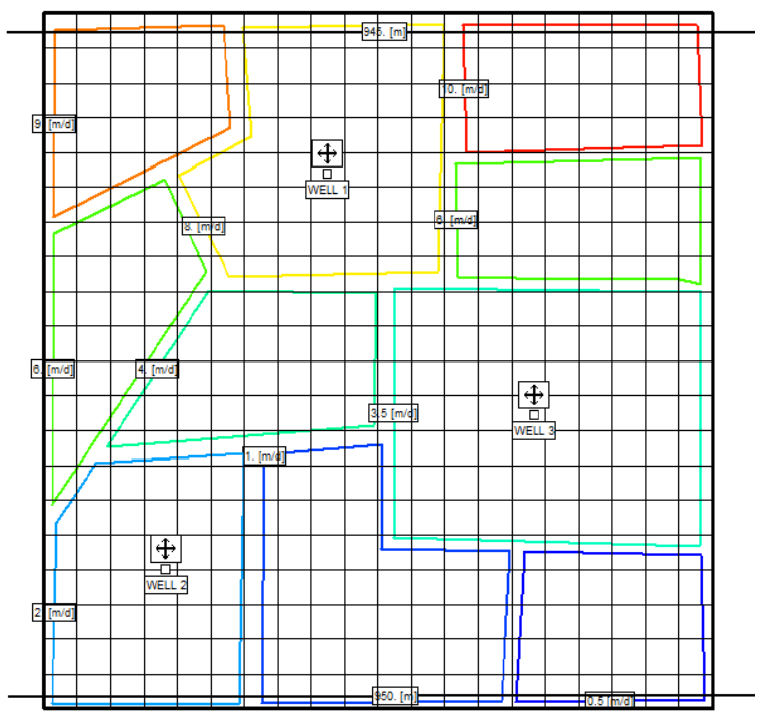
Figure 1. Hydraulic conductivity spatial configuration and location of pumping wells for the proposed synthetic model.